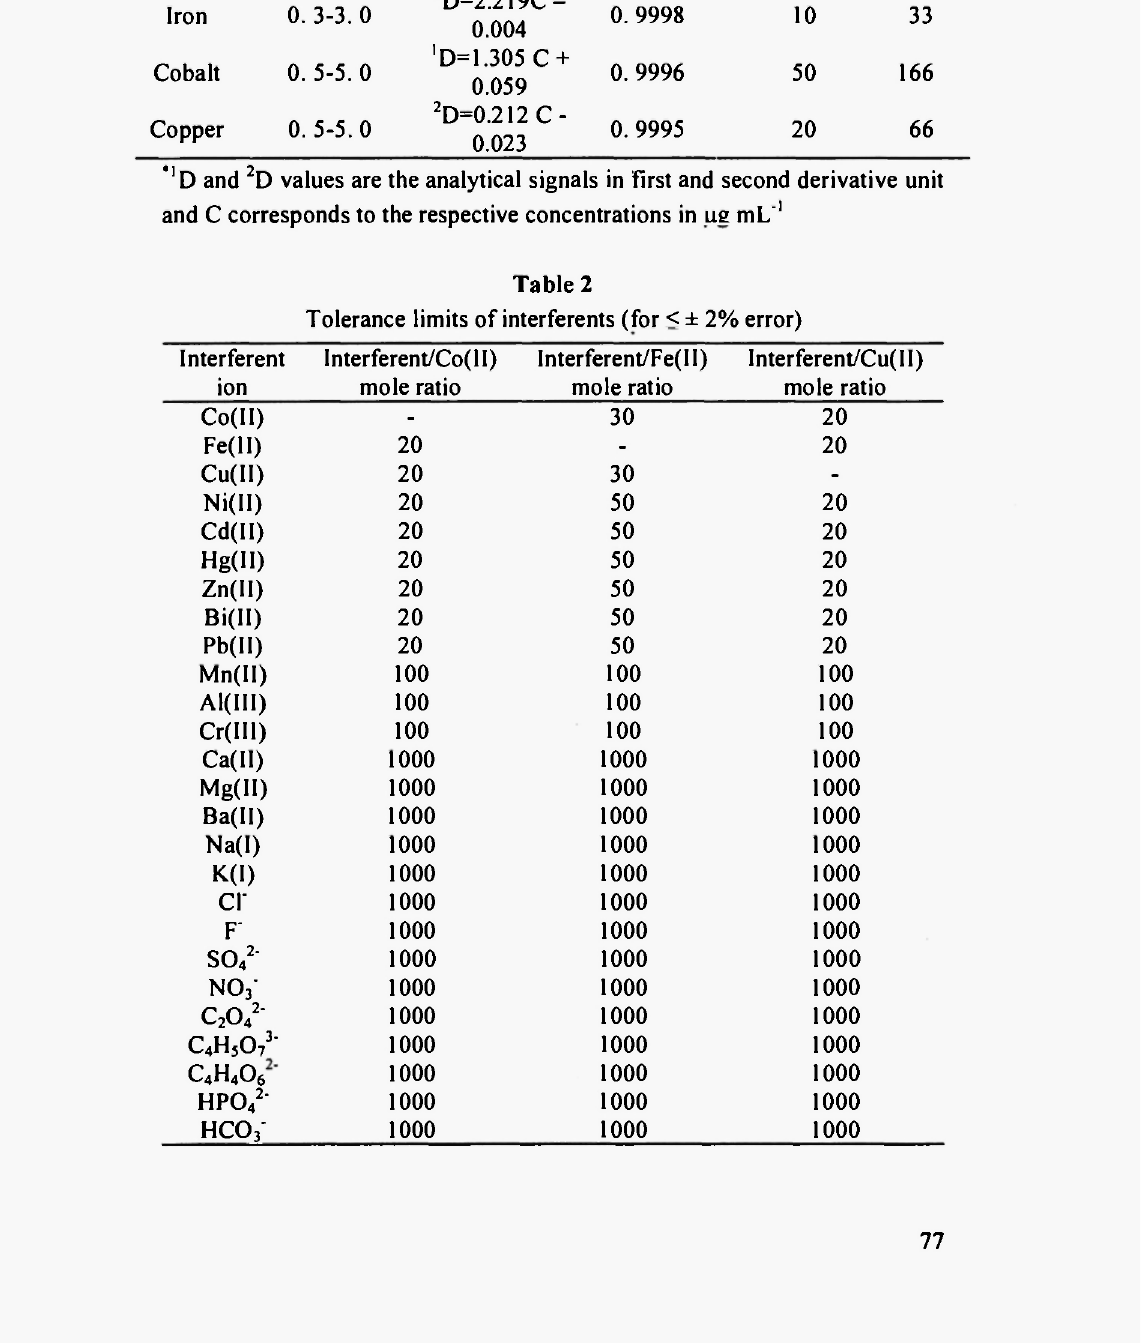
Calibration equations for derivative